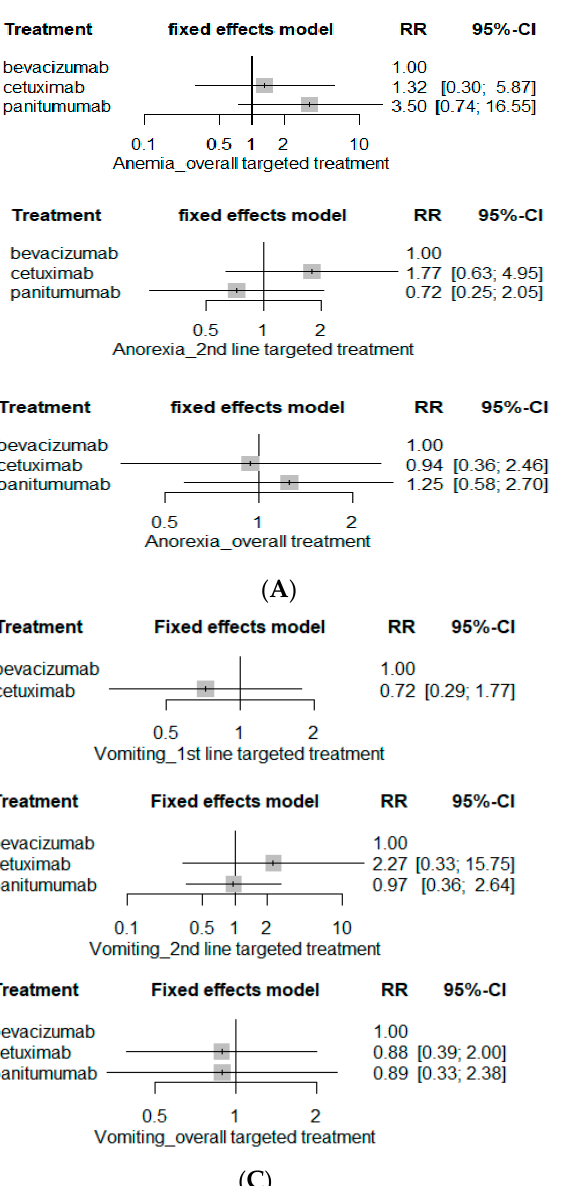
Figure 4. Hematological SAE risks. ( A ) Anemia; ( B ) febrile neutropenia; ( C ) neutropenia; ( D ) infec- tion; and ( E ) thrombocytopenia.